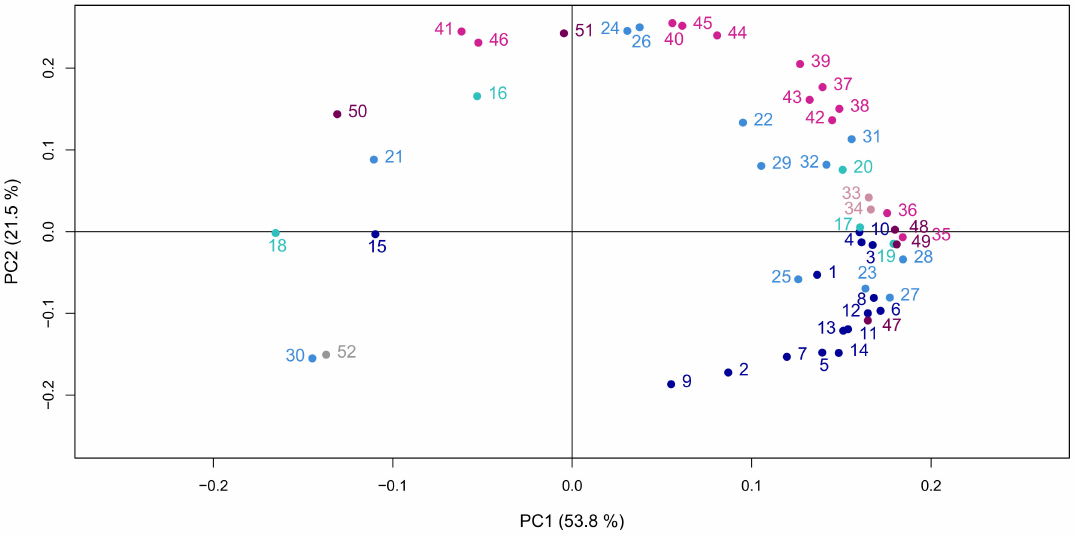
Figure 3. PCA showing the loading plot of the metabolites. The metabolites are coloured with respect to their chemical identity: amino acids and derivatives (dark blue), carbohydrates and derivatives (light blue), tricarboxylic acids (teal), cyanogenic glycosides (pink), flavonoids (fuchsia), coniferyl alcohol derivatives (plum), and inorganic compounds (grey). The metabolites are identified as follows: